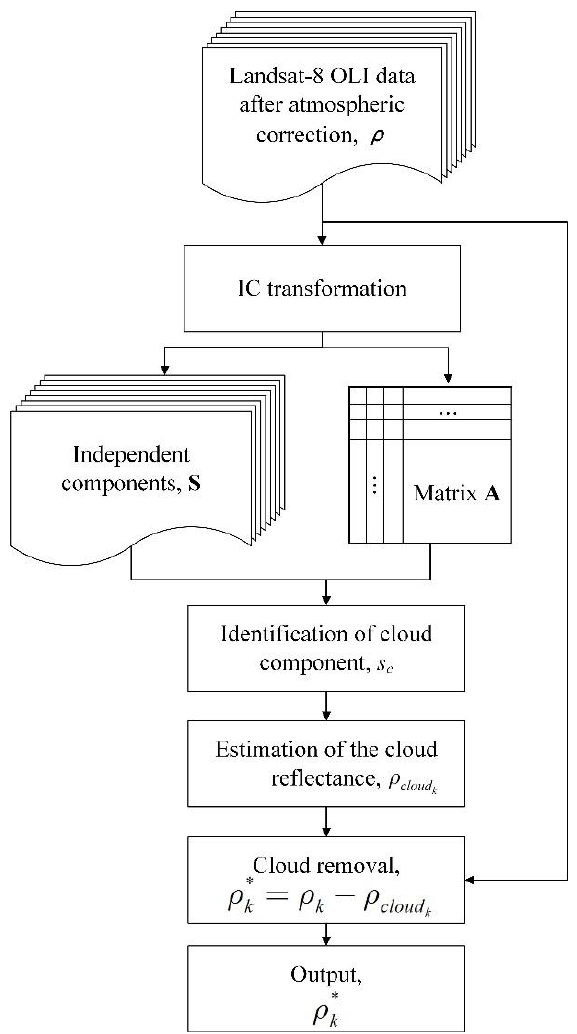
Figure 1. The algorithm to remove clouds using the independent component